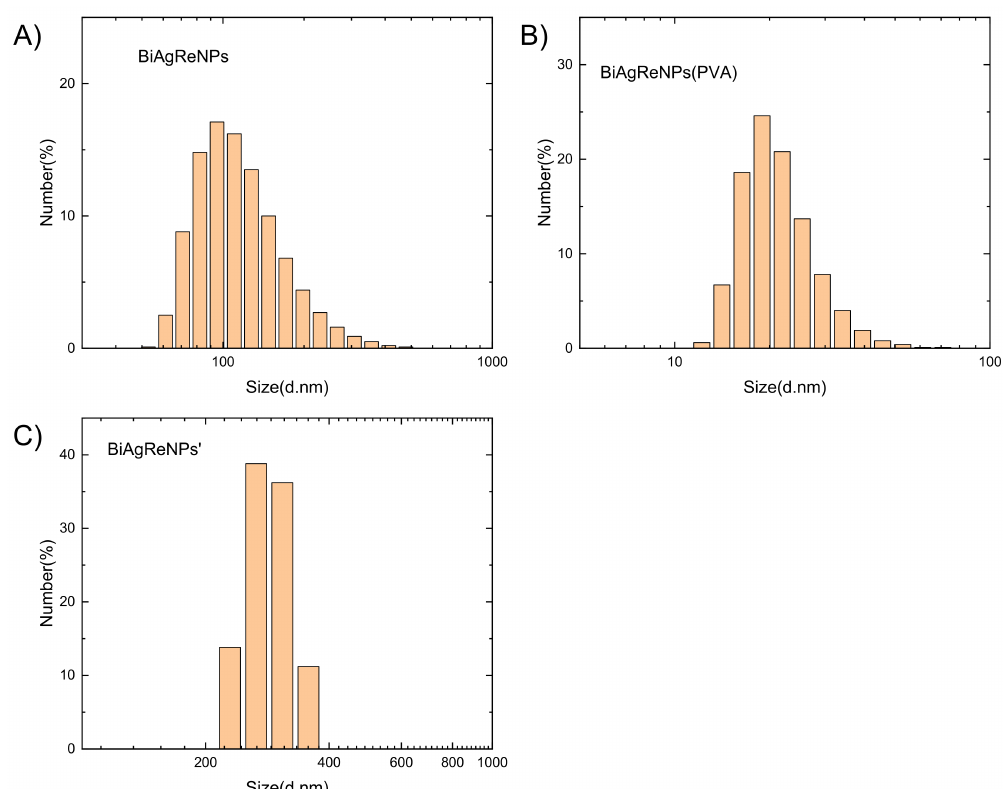
Figure 10. DLS analysis results in the form of particle size histograms according to distribution for ( A ) a solution of silver–rhenium–bismuth nanoparticles synthesized without a stabilizer (PVA), ( B ) a solution of silver–rhenium–bismuth nanoparticles synthesized in the presence of a stabilizer. Silver, rhenium, and bismuth concentration was 1 × 10 − 4 mol/dm 3 , ( C ) silver–rhenium–bismuth synthesized in the presence of a stabilizer. Both rhenium and bismuth concentrations were 1 × 10 − 3 mol/dm 3 , while silver concentration was 1 × 10 − 4 mol/dm 3